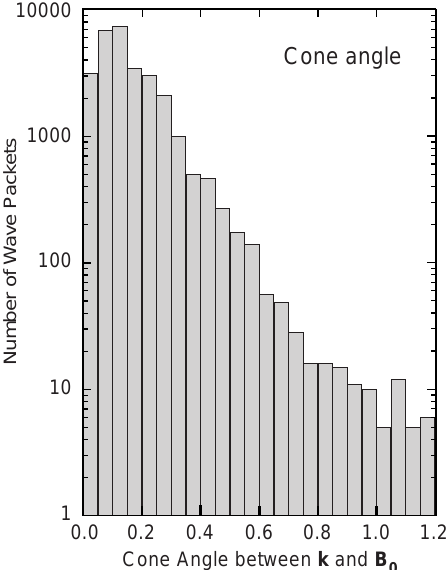
Fig. 7. Occurrence distribution of cone angle between lion roar wave vector and ambient magnetic field